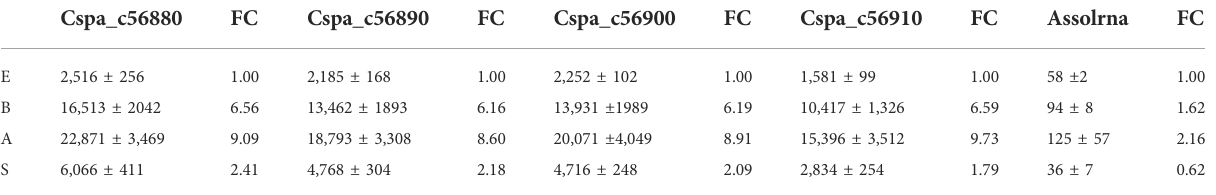
TABLE 1 Mean NPKM values of sol mRNA displayed for every gene and Assolrna for different growth